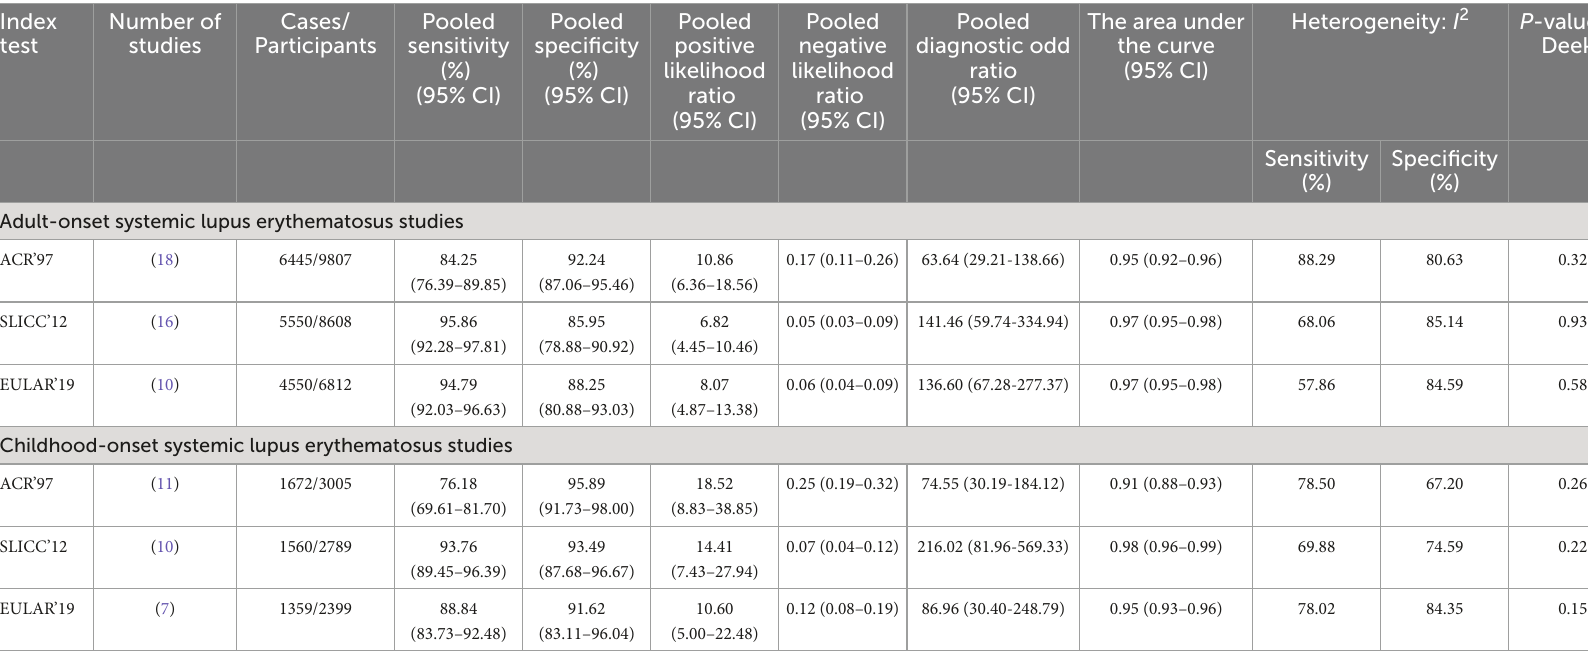
TABLE 1 Diagnostic performance of the ACR 1997, SLICC 2012, and EULAR/ACR 2019